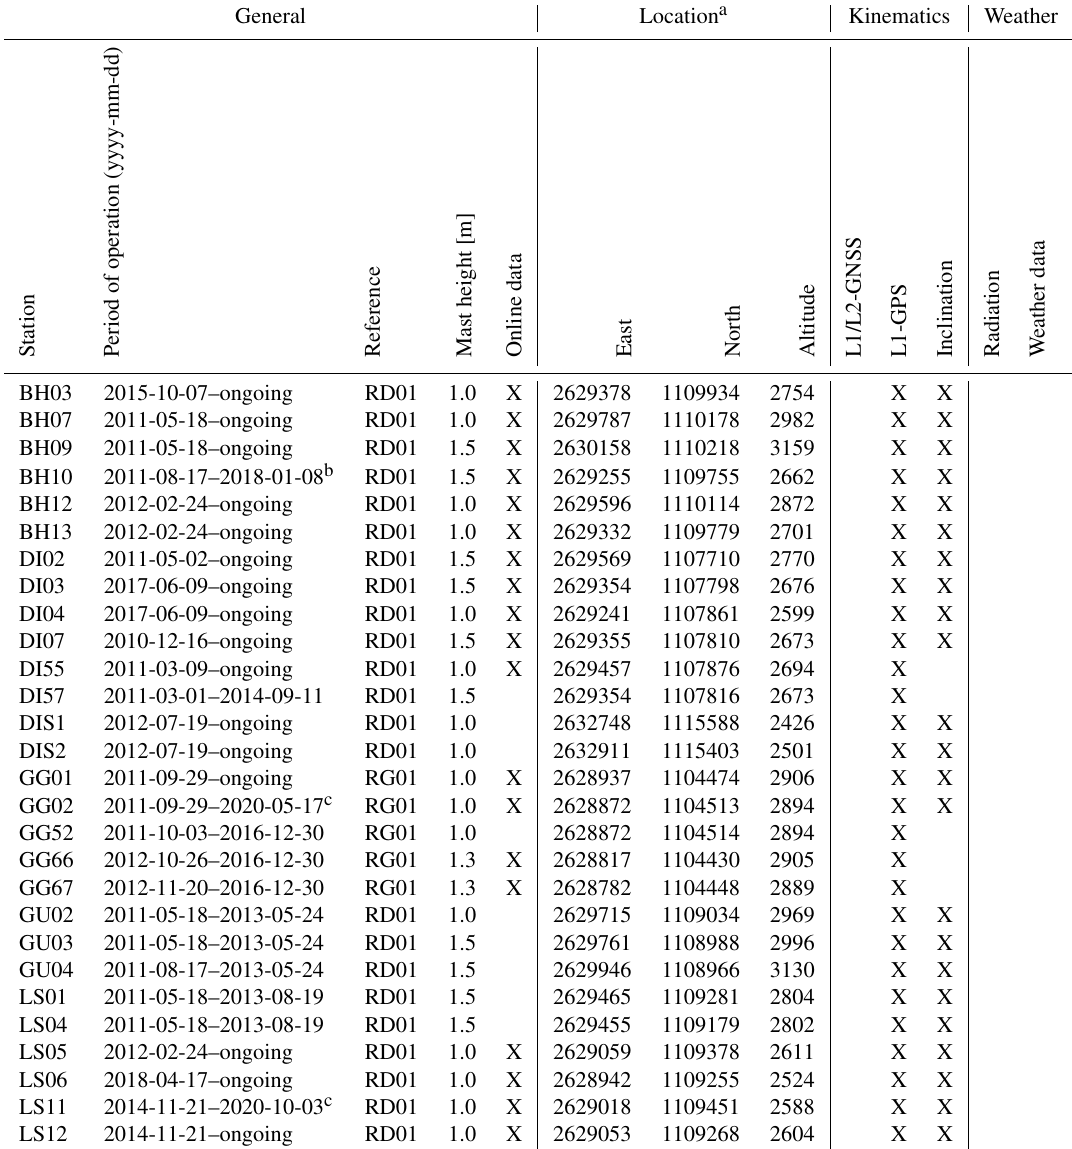
Table A1. Per position overview of the sensors in the Matter Valley field site (see Fig. 2): Part 1. General Location a Kinematics